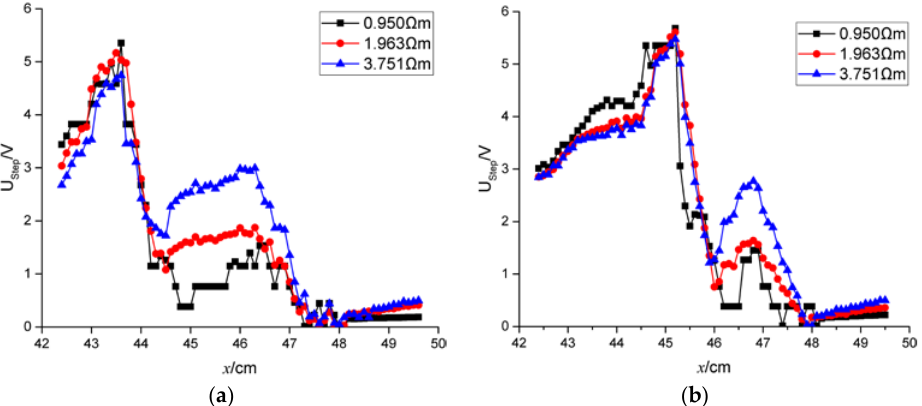
Figure 8. The changes in step voltage with agar gel resistivity under different agar gel sizes. ( a ) The changes in step voltage with agar gel resistivity when the size of the agar gel is 26 cm × 26 cm. ( b ) The changes in step voltage with agar gel resistivity when the size of the agar gel is 23 cm × 23 cm.